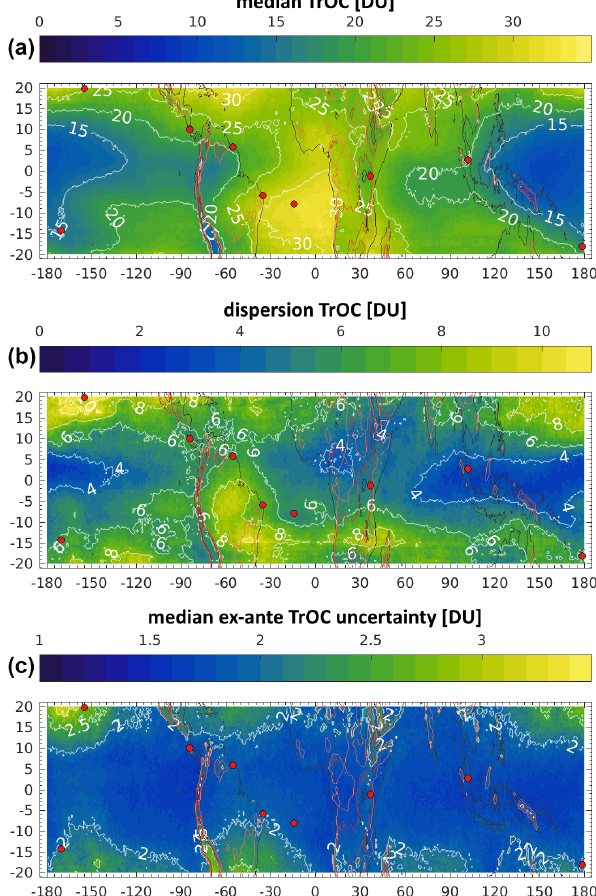
Figure 1. Statistics of 2 years of TROPOMI tropospheric O 3 col- umn data (1 May 2018–30 April 2020): (a, b) median and 68% interpercentile of tropospheric ozone column; (c) median ex ante tropospheric ozone column uncertainty. Data are screened accord- ing to the recommendations given by the data providers. Red mark- ers show the location of the SHADOZ sites considered in this study. Red isolines trace the 500, 1000 and 2000m surface elevation lev- els. Corresponding sampling statistics and time are shown in Fig. S1 in the